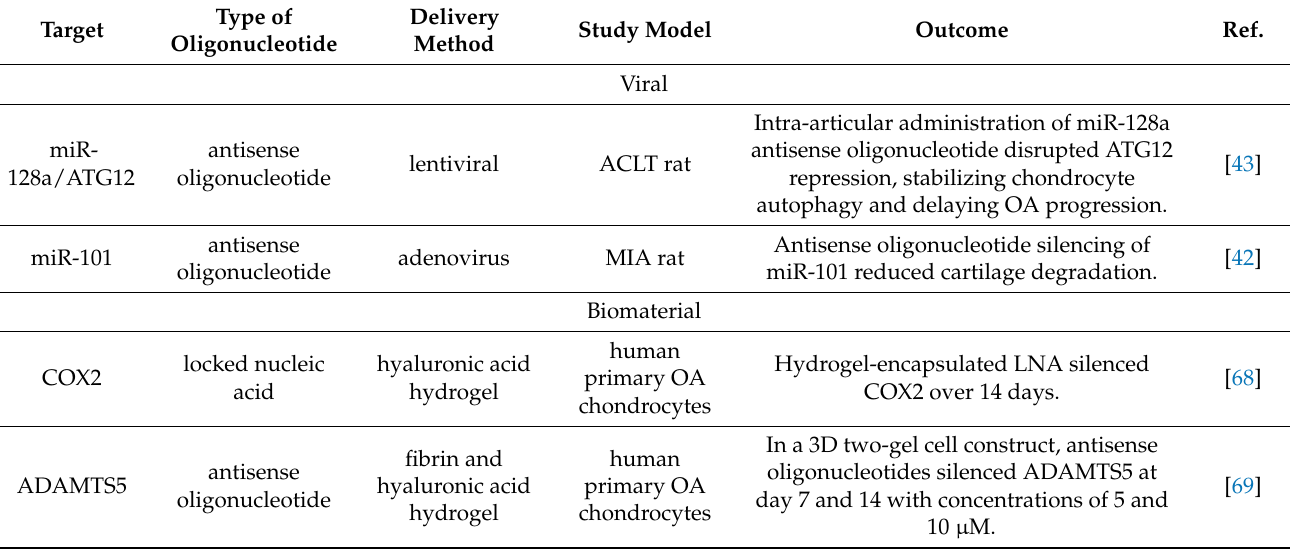
Table 2. Summary of studies optimising oligonucleotide